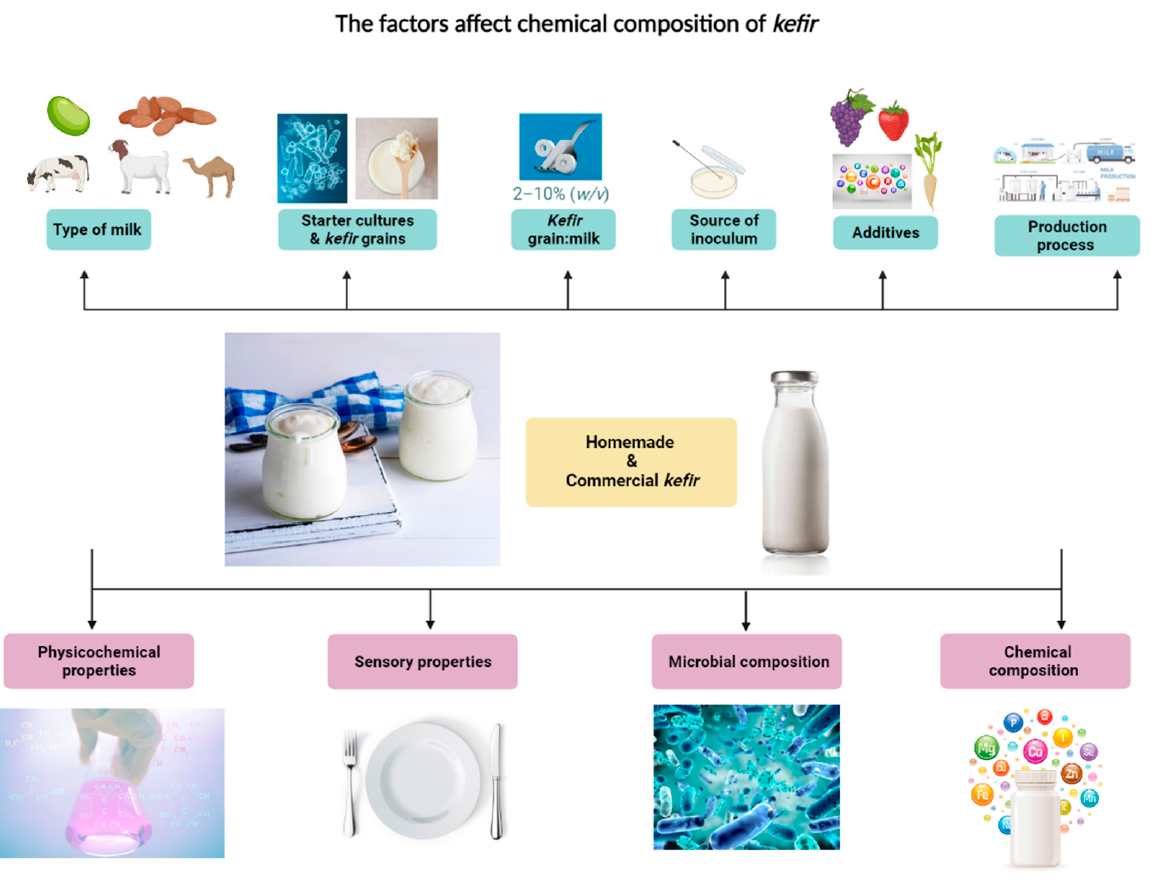
Figure 1. The factors that affect the composition of kefir (this figure was created using images from Pixabay (https://pixabay.com, accessed on 4 October 2022) and Biorender (https://app.biorender.com/, accessed on 4 October 2022).